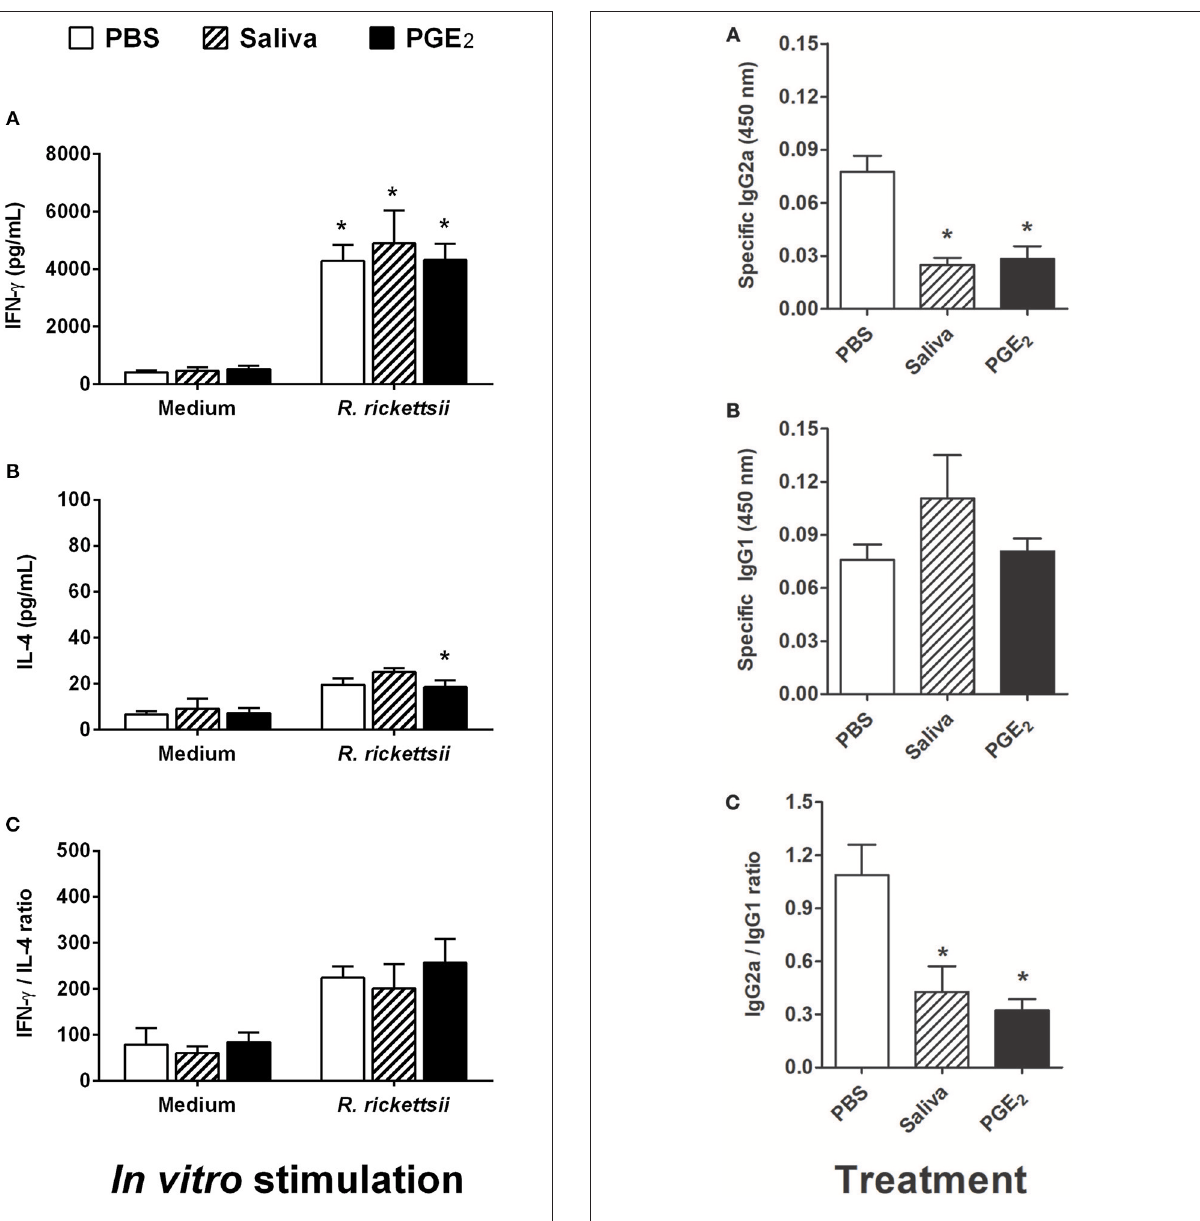
FIGURE 7 | Adoptive transfer of murine DCs incubated with R. rickettsii and treated with A. sculptum saliva or PGE 2 decreases specific IgG2a without changing IgG1 levels in serum. Bone marrow cells from C3H/HePas mice were differentiated into DCs, seeded at 10 6 cells/well in 24-well plates and preincubated for 1h with medium only, A. sculptum saliva collected by pilocarpine stimulation from female ticks fed on host for 7–9 days (1:50 dilution) or PGE 2 (100nM). Cells were incubated with R. rickettsii (10 7 bacteria) during 18h, collected and washed to remove unbound bacteria. Mice were injected subcutaneously with 10 6 DCs of each group in a 100 µ L volume. During the first 5 days after DC transfer, animals of each group received a subcutaneous treatment (100 µ L at the same site of DC inoculation) as follows: PBS, A. sculptum saliva (1:50 dilution) and PGE 2 (100nM). After 30 days of DC transference, a blood aliquot was collected and the levels of R. rickettsii -specific IgG2a (A) and IgG1 (B) antibodies were evaluated in serum samples by ELISA. The IgG2a/IgG1 ratio is also presented (C) . Results are expressed as the mean ± SEM. * p ≤ 0.05 vs. “DC + R. rickettsii /PBS”